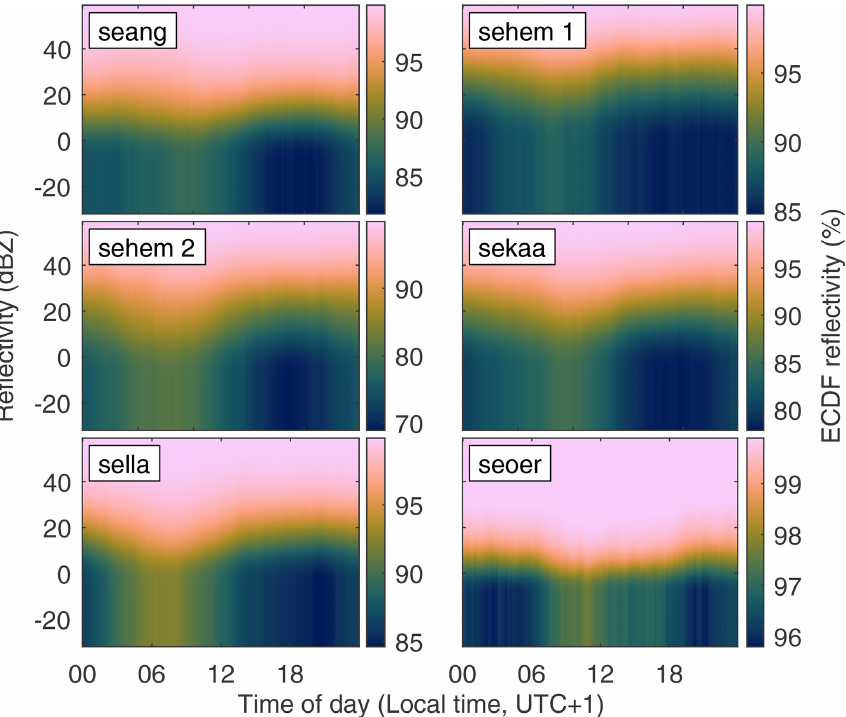
Figure 7. Empirical cumulative distribution function of reflectivity values for all selected groups of radar cells as a function of the time of day.